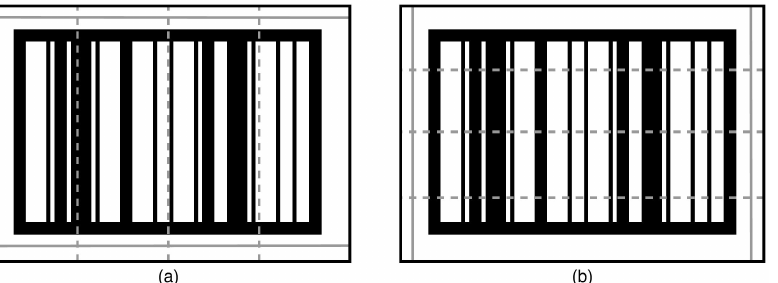
Figure 6. Diagram showing the two combinations of sample lines. ( a ) two horizontal and three vertical sample lines, ( b ) three horizontal and two vertical sample lines.